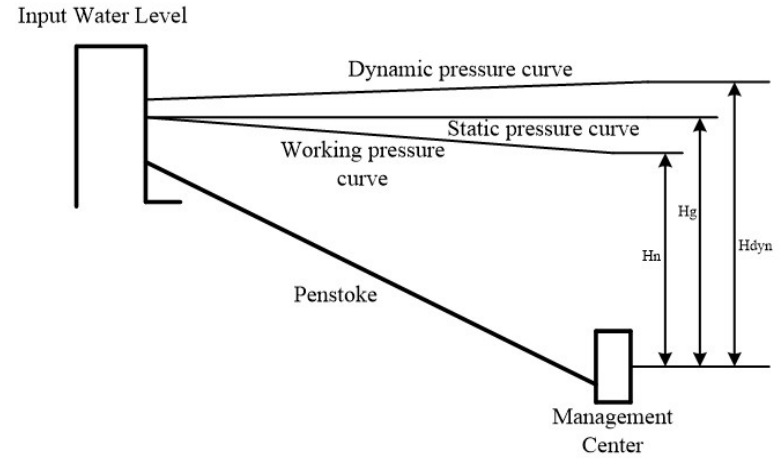
Figure 4. Principle scheme of hydroelectric power system [39].